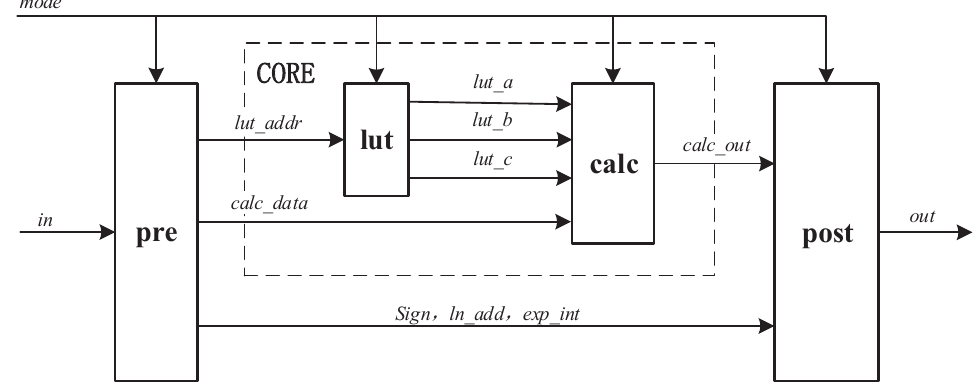
Figure 6. Floating-point transcendental function hardware architecture, where pre represents the preprocessing module, lut represents the lookup table module, calc represents the calculation module and post represents the postprocessing module.